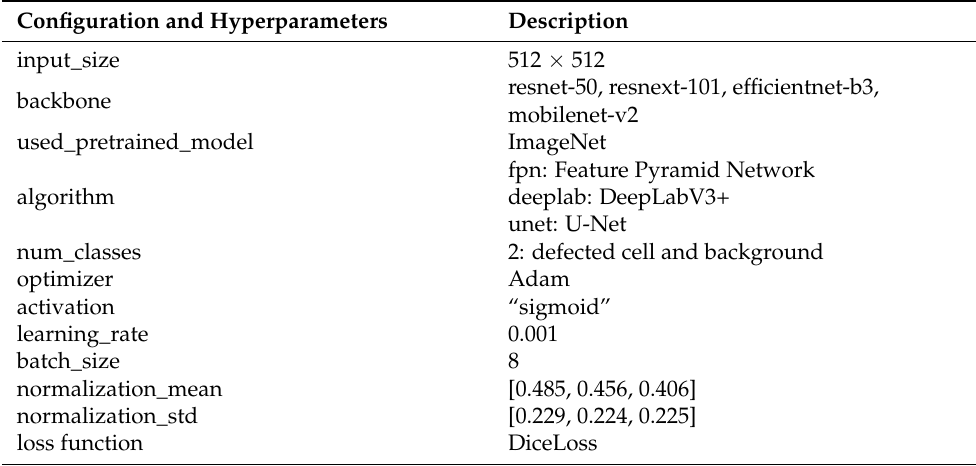
Table 3. Configuration and hyperparameters specifications of implemented